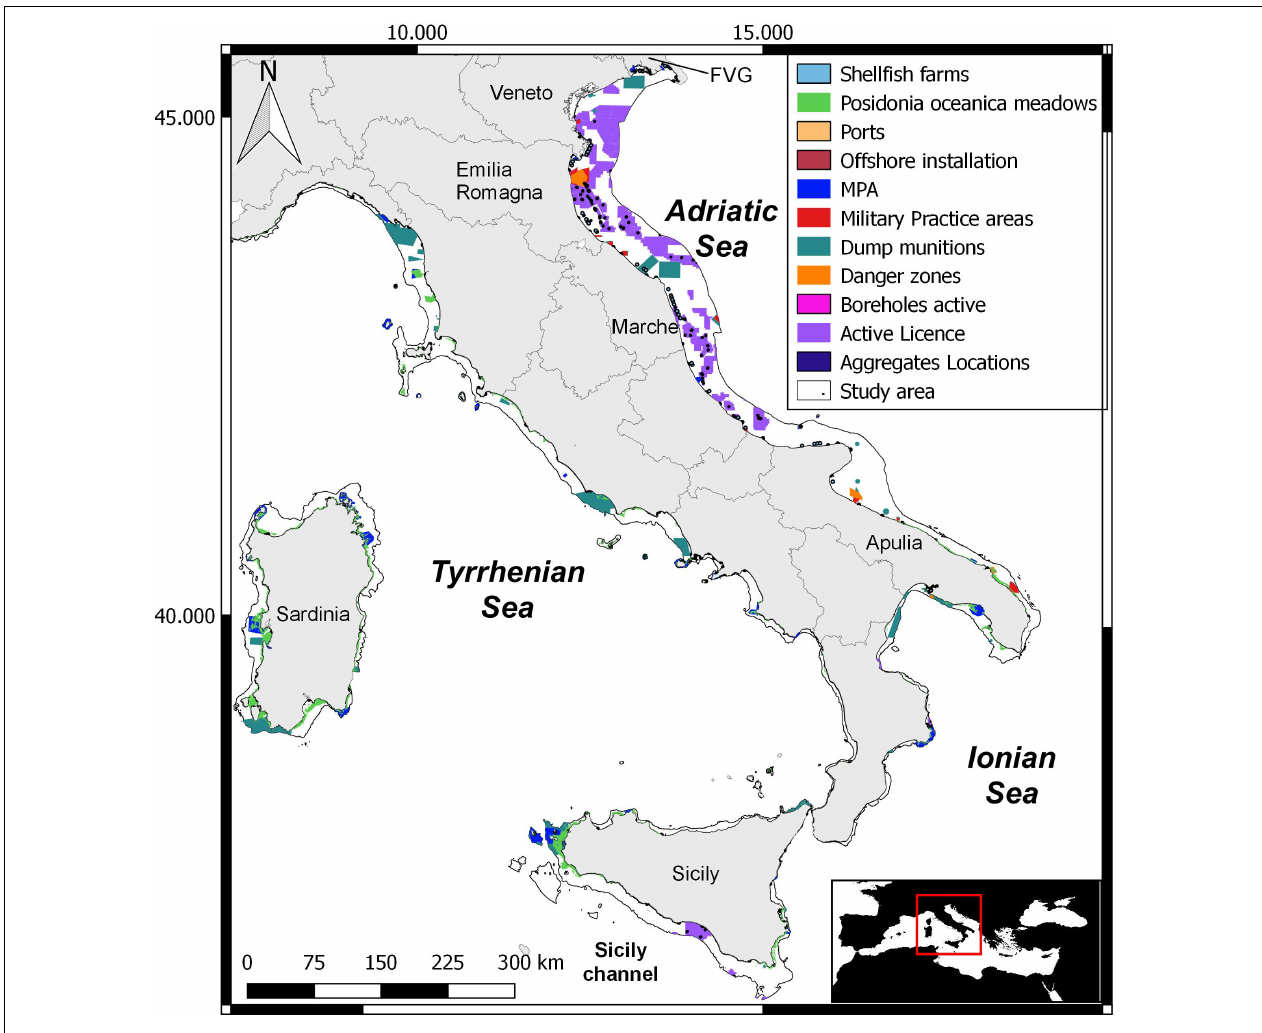
FIGURE 1 | Study area within the Italian EEZ and maps of anthropogenic and natural constraints: commercial harbor, shellfish farm, Posidonia oceanica meadows, Marine Protected Area (MPA), dredging, military practice area, danger zones, hydrocarbon extraction (active licenses), and dump munitions.